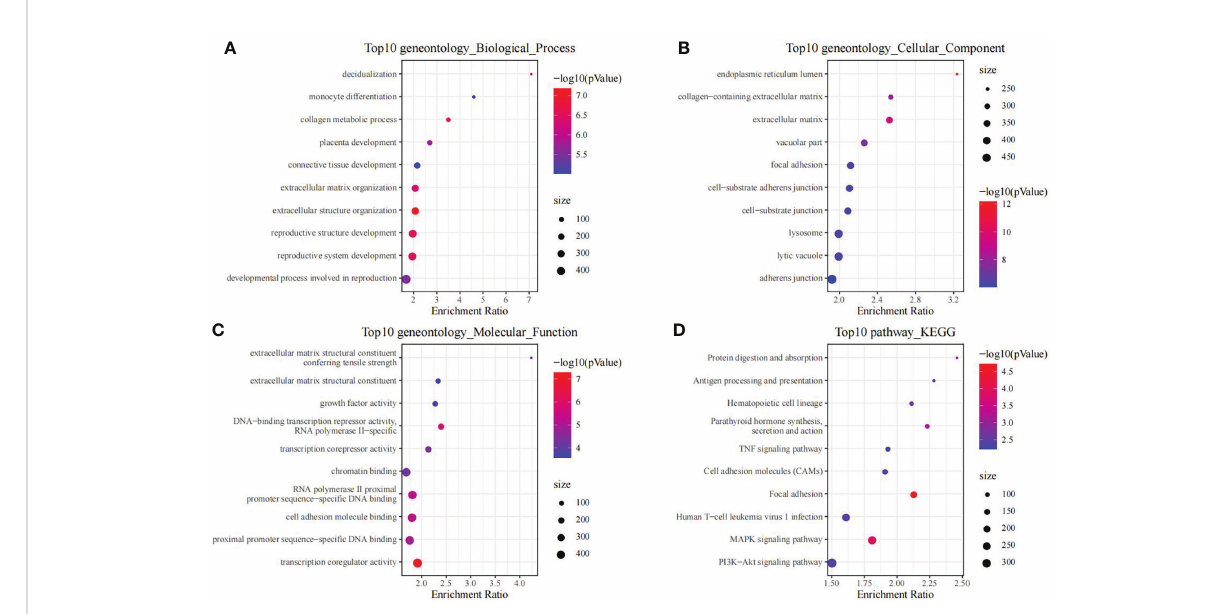
FIGURE 5 The functional analysis of upregulated DEGs between OP samples and normal samples in training set. GO biological process (A) , GO cellular component (B) , GO molecular function (C) and KEGG (D) enrichment analysis of